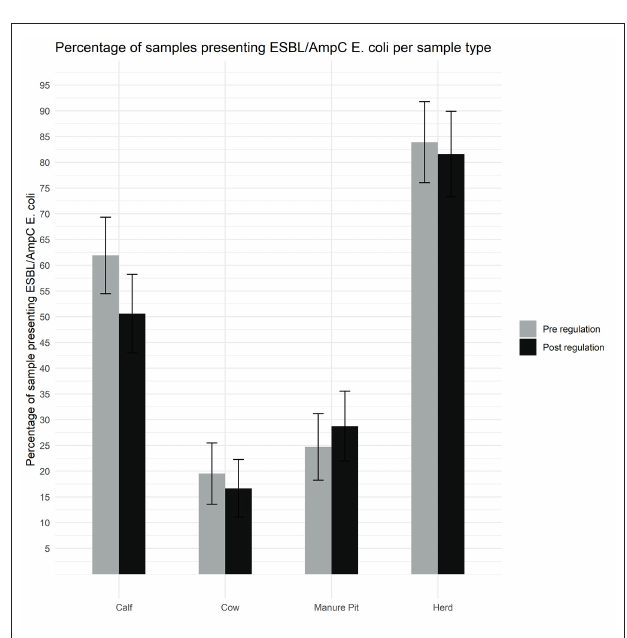
FIGURE 5 | Comparison of the proportion of isolates with a putative ESBL/AmpC Escherichia coli per sample type (manure pit, cows, calves, herd) from 87 dairy farms from Québec, Canada, pre (gray) and post (black) regulation